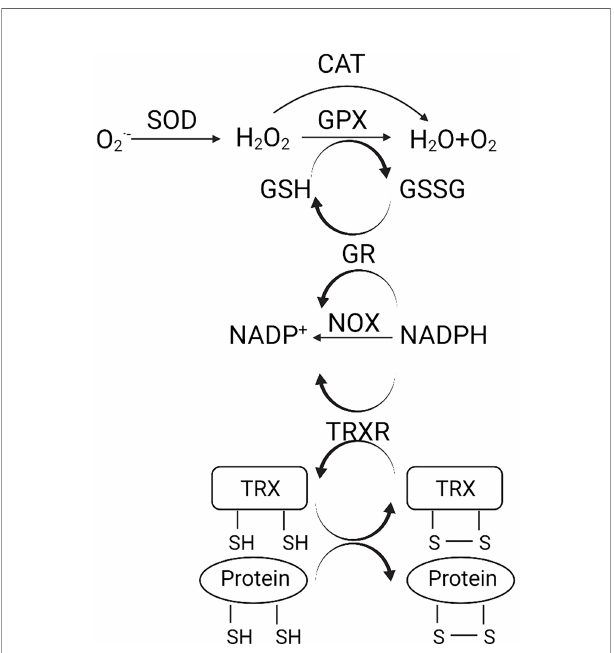
FIGURE 1 | (Created with Created with BioRender.com). Schematic diagram of the antioxidant system. O − 2 , superoxide anion; H 2 O 2 , hydrogen peroxide; CAT, catalase; GPX, glutathione peroxidase; SOD, superoxide dismutase; GSH, glutathione; GSSG, oxidized glutathione; NADPH, nicotinamide adenine dinucleotide phosphate; NOX, NADPH oxidase; GR, glutathione reductase; TRX, thioredoxin; TRXR, TRX